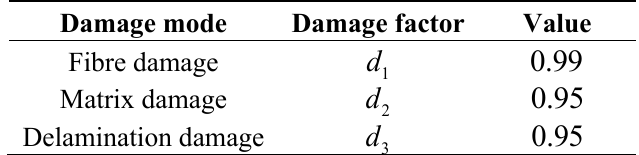
Table 3. Specific values of corresponding damage